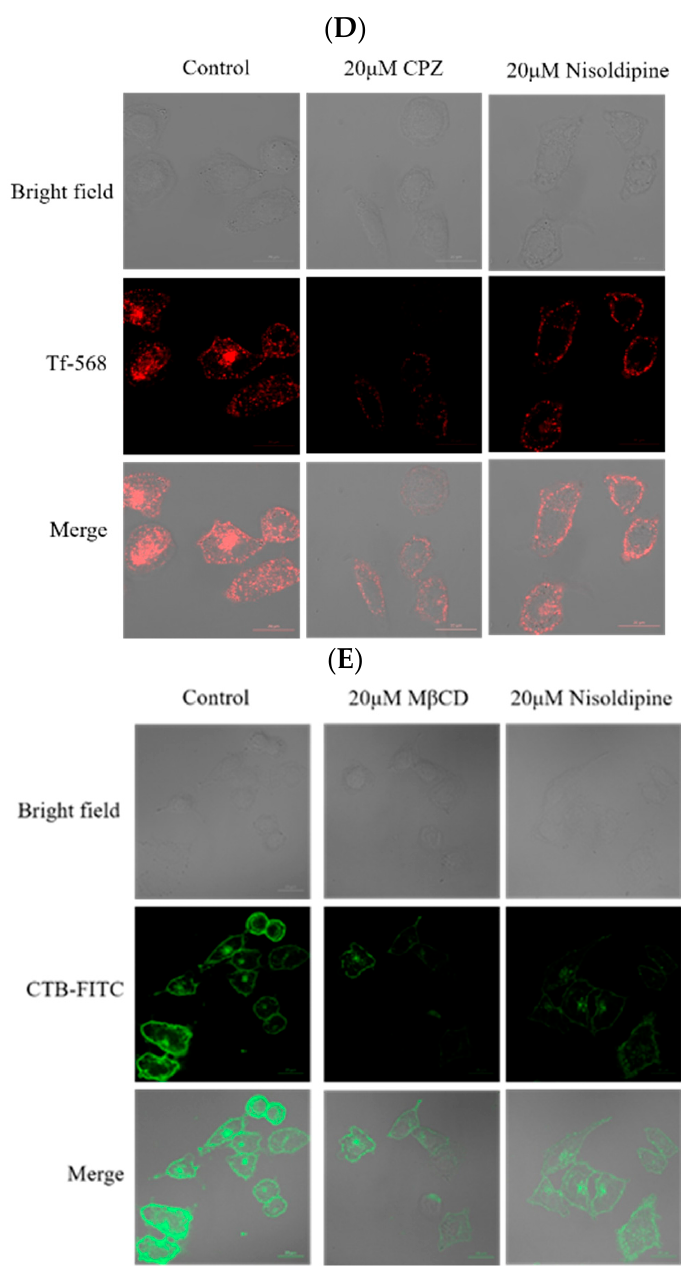
Figure 4. Nisoldipine inhibits endocytosis of IAV. ( A ) Nisoldipine could reduce the absorption of transferrin. A549 cells were pretreated with nisoldipine for 3 h and then incubated with transferrin (15 μ g/mL) at 37 °C for 30 min. The cells were lysed with RIPA and then subjected to Western blotting with a rabbit anti-transferrin mAb. ( B ) Nisoldipine could reduce the number of clathrin- encapsulated endocytic vesicles. Scale bar: 500 nm. Magnification: 40,000×. Red arrows point to the clathrin-coated vesicle. ( C ) Nisoldipine could reduce the expression of caveolin-1. ( D ) Transferrin uptake was decreased when the cell was pretreated with nisoldipine. CPZ was used as a positive control. Scale bar: 20 μ m. Tf-568 is shown in red. ( E ) The marked reduction of CTB endocytosis was observed in nisoldipine-treated cells. M β CD was used as a positive control. CTB-FITC is visualized in green. Data are presented as mean ± SD (** p < 0.01, *** p < 0.001).